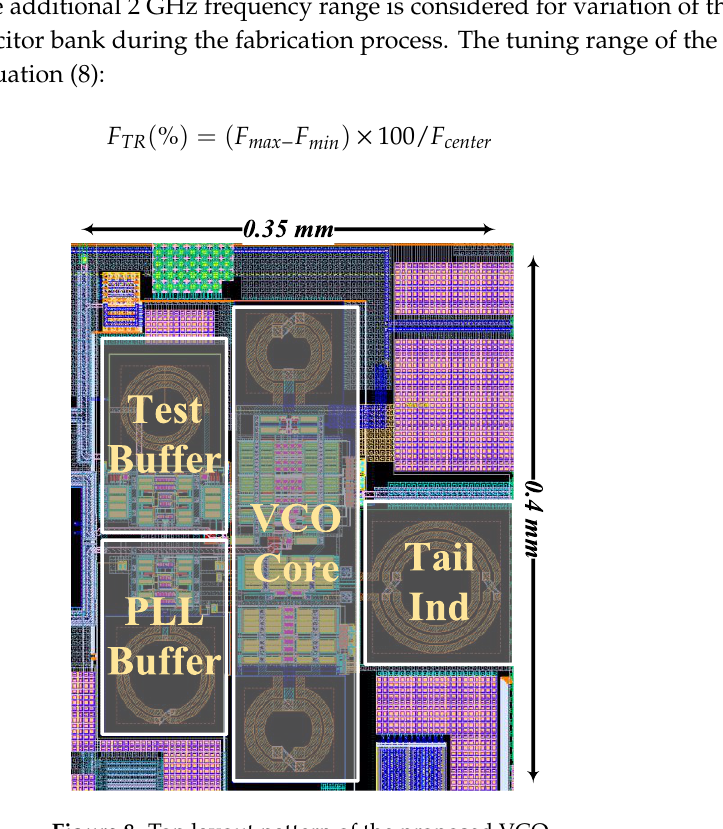
Figure 8. Top layout pattern of the proposed VCO.